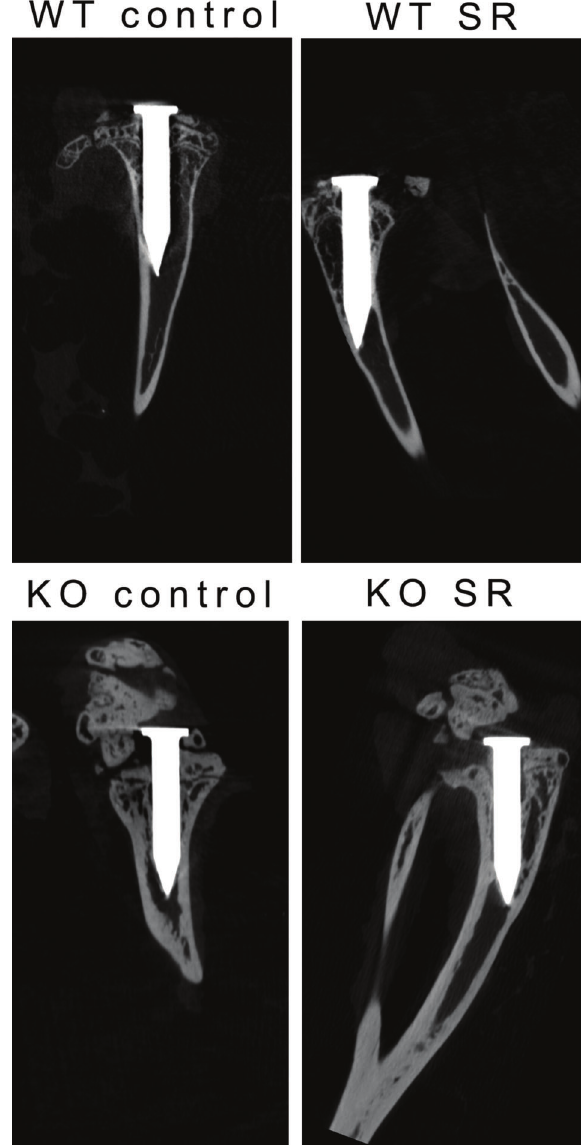
Figure 2. Sagittal-sectional micro-computed tomography scans of titanium implants. SR: strontium ranelate; WT: wild type; KO: